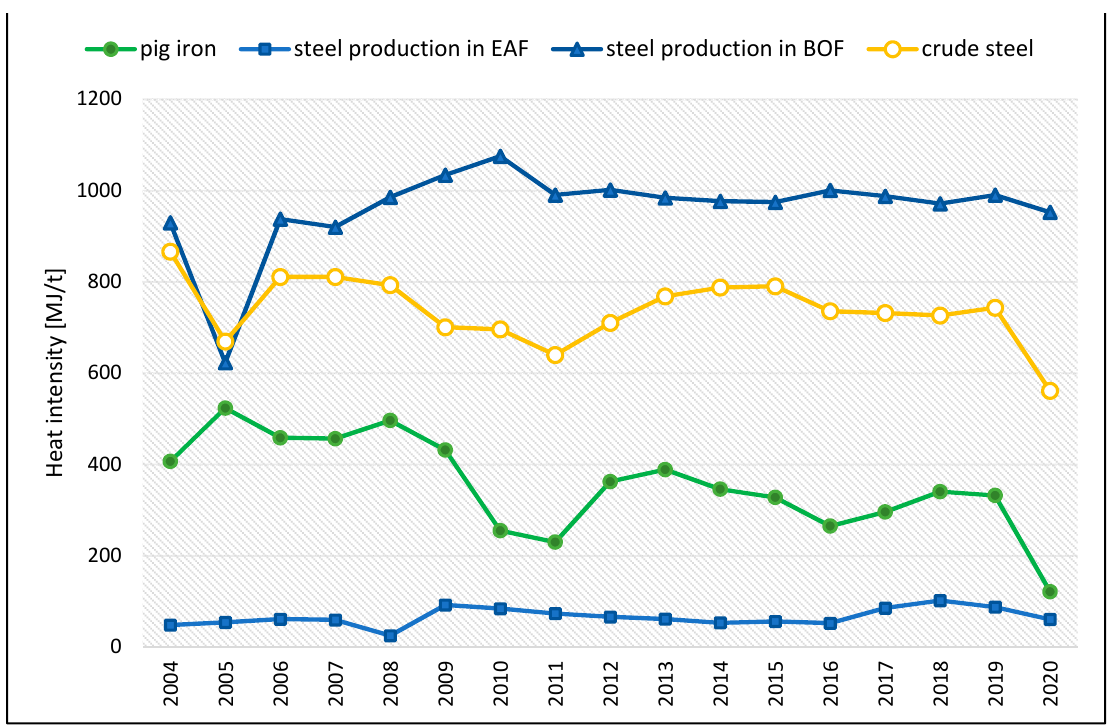
Figure 4. Heat intensity per 1 tonne of steel in all the metallurgical processes in Poland from 2004 to 2020. Source: Own elaboration.